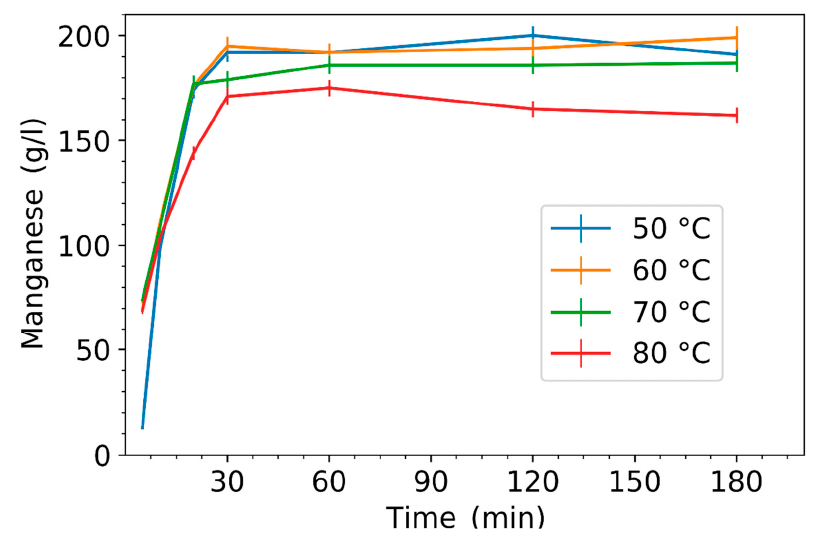
Figure 3. Manganese concentration as a function of time at 50, 60, 70 and 80 °C (S/L ratio 420 g/L, H 2 O 2 ).